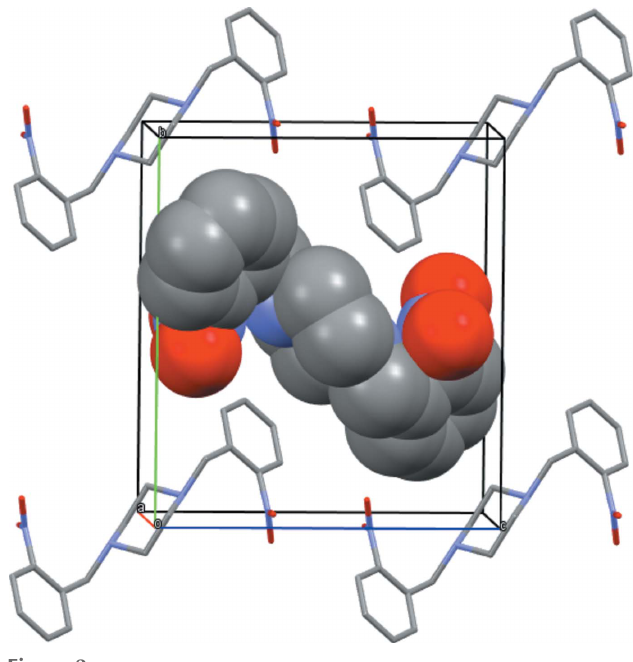
Figure 2 A view approximately along [100] of the unit-cell